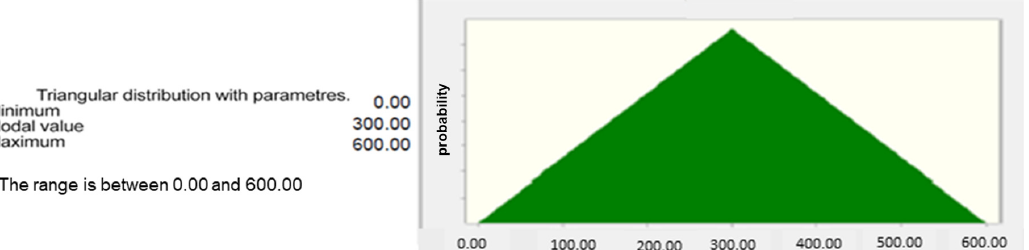
Table 3. Summary of the statistics obtained by Monte Carlo analysis. Source: Crystal Ball software. Figure 2. Triangular distribution of an activity hypothesized in the model, concerning the variable “Restructuring costs”. Processing obtained from Crystal Ball software (version 11.1.2.4 , Oracle, Redwood City, CA, USA).